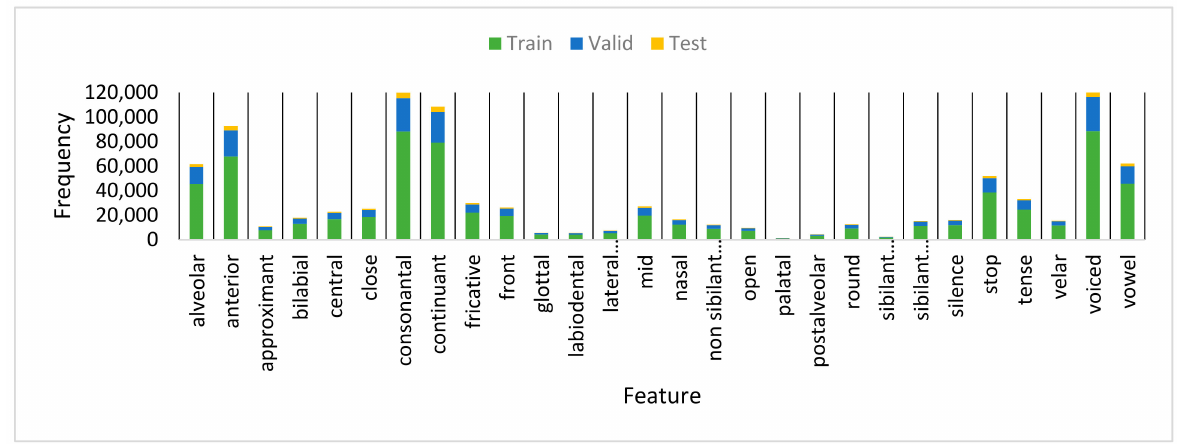
Figure 4. Occurrences of the AF classes on the training, validation, and testing sets of